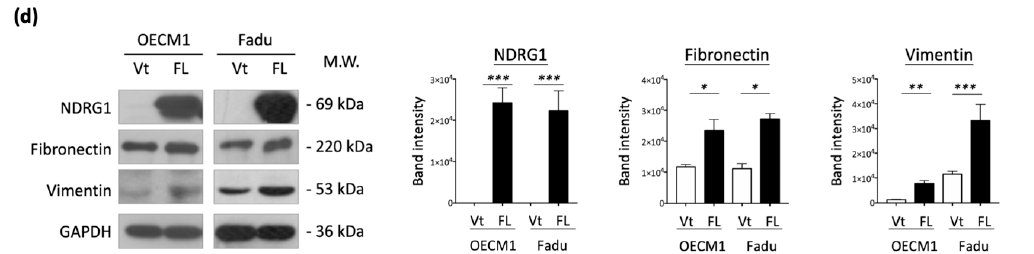
Figure 3. NDRG1 promoted cell motility via ECM mechanism. ( a ) NDRG1 facilitated cell migration